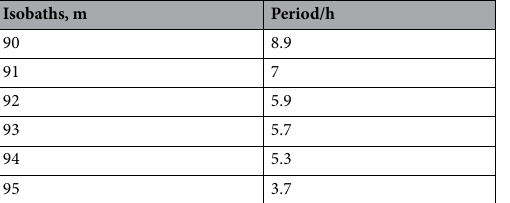
Table 2. Period of the first longitudinal mode as a function of the isobaths.